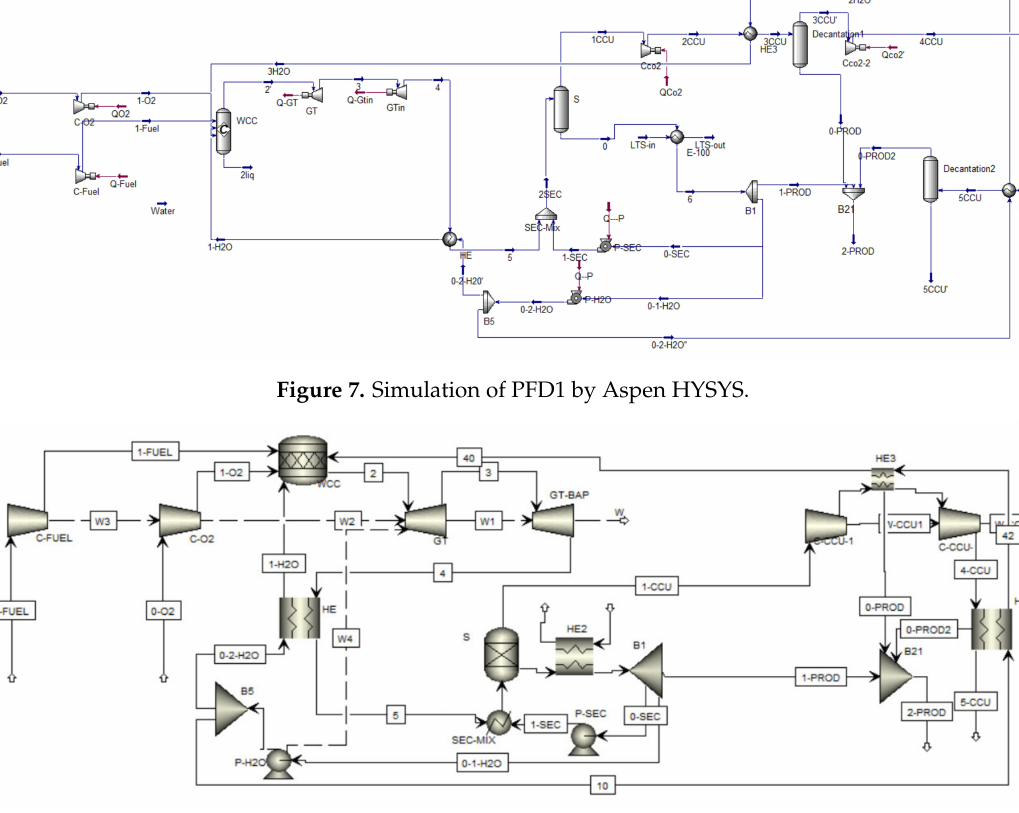
Figure 8. Simulation of PFD1 by Aspen Plus.